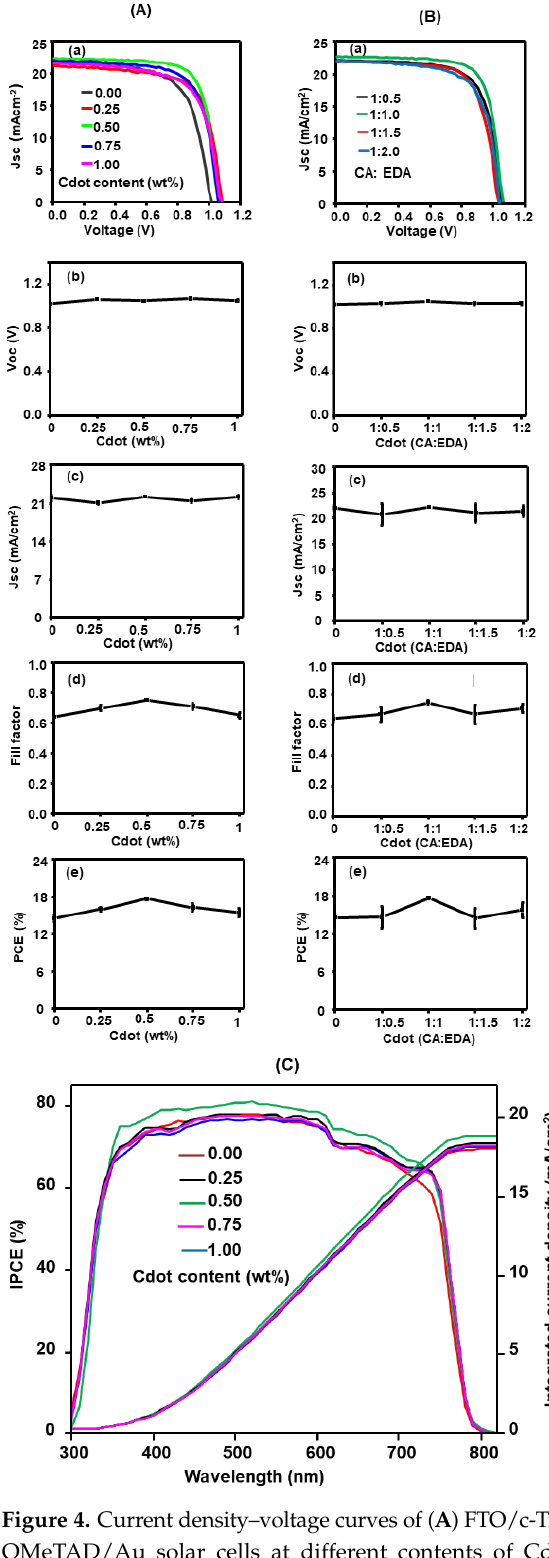
Figure 4. Current density–voltage curves of ( A ) FTO/c-TiO 2 /meso-TiO 2 /Cdot (1:1)/perovskite/spiro- OMeTAD/Au solar cells at different contents of Cdot and ( B ) FTO/c-TiO 2 /meso-TiO 2 /Cdot (1.0 wt%)/perovskite/spiro-OMeTAD/Au solar cells at different CA: EDA mol ratios of Cdot. ( a ) J–V curve; ( b ) V oc ; ( c ) J sc ; ( d ) fill factor; and (e) PCE. ( C ) IPCE spectra of perovskite solar cells at different contents of Cdot.